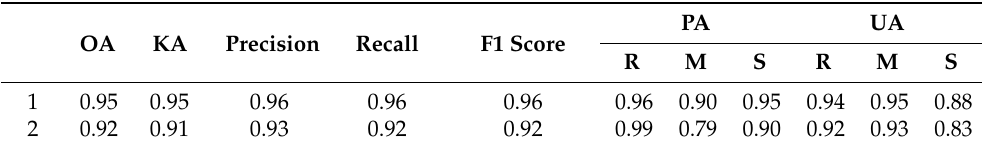
Table 7. Accuracy assessment of crop classification by the IO-Growth method and time-series method. Note that numbers of methods are